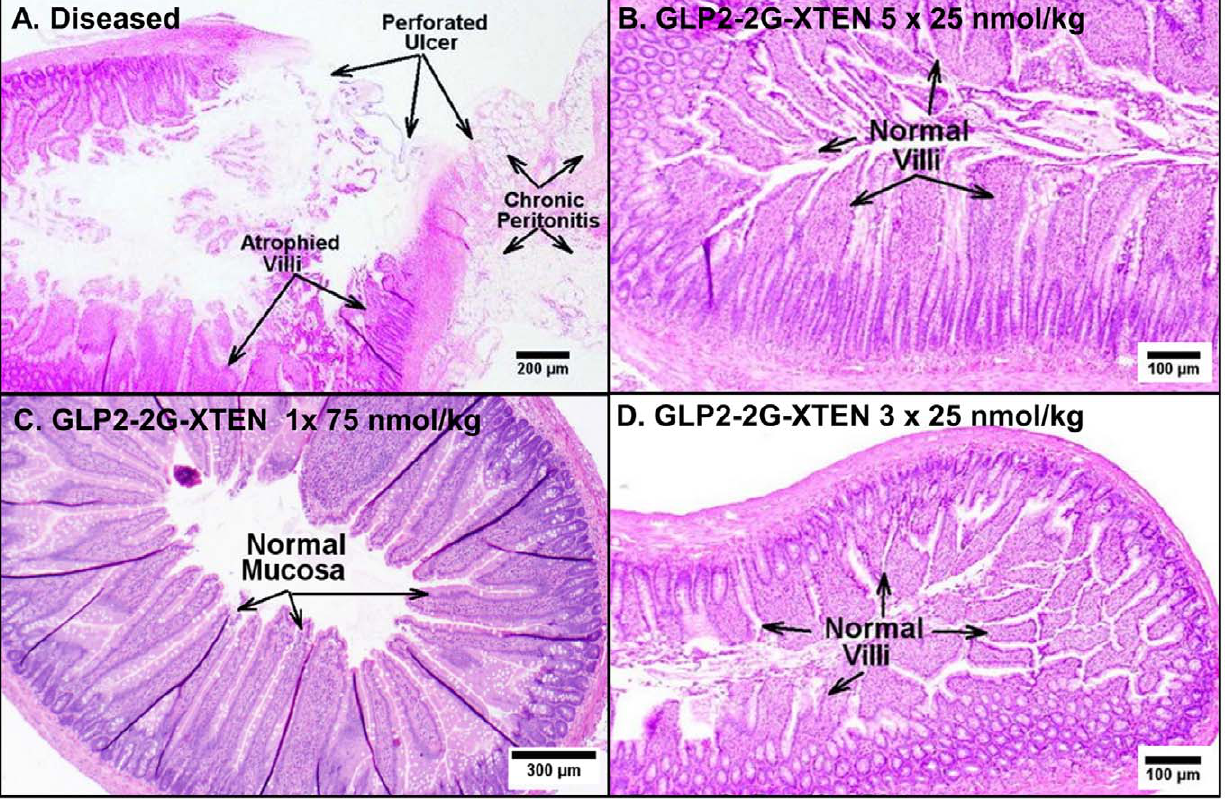
Figure 6. GLP2-2G-XTEN administration improves small intestine histopathology in the indomethacin-induced rat disease model. A) Hematoxylin and eosin staining of jejunum sections from A) diseased, vehicle-treated rats, B) diseased, GLP2-2G-XTEN high dose treated rats (125 nmol/kg total dose divided into five daily 25 nmol/kg doses), C) diseased, GLP2-2G-XTEN low dose treated rats (75 nmol/kg total dose given once on day 2 3) and D) diseased, GLP2-2G-XTEN low dose treated rats (divided into three 25 nmol/kg doses on day 2 3, 2 1 and 1).